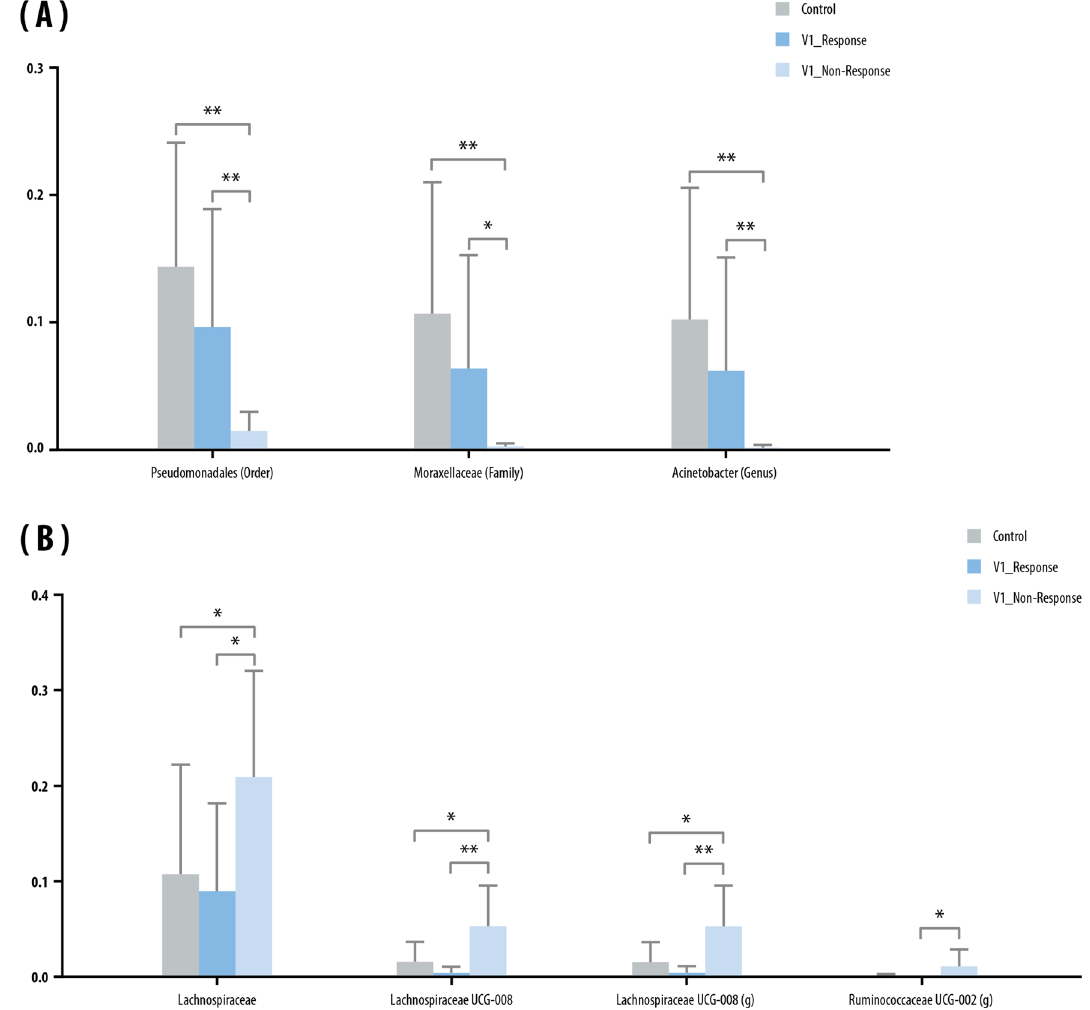
Figure 5. Urine: microbials abundant in the urine of the control and inflammatory bowel disease (IBD) groups before anti-TNF-α treatment (V1). Mean relative abundance of: ( A ) microbials abundant in the responder group; and ( B ) microbials abundant in the non-responder group. Kruskal–Wallis and Wilcoxon tests were used. Bars above columns indicate standard deviation. * p < 0.05; ** p <